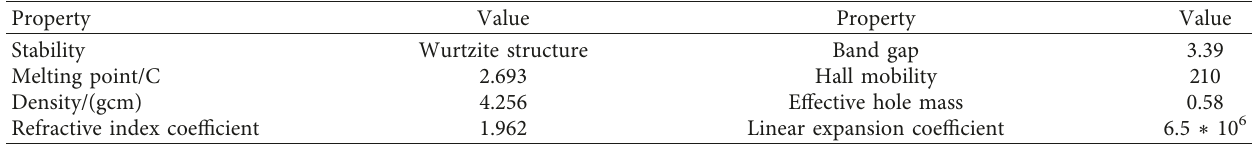
Table 2: Characteristic parameters of hexagonal fibril ore.